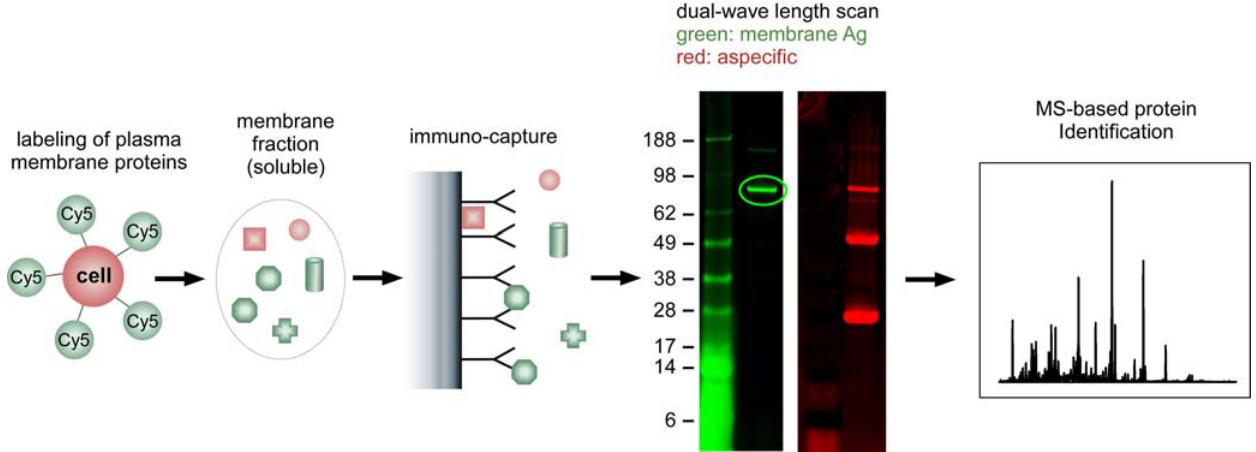
Figure 4. Schematic outline of the biochemical strategy adopted for the identification of the target antigens. Membrane proteins on living cells are selectively labeled with fluorescent dyes (i), then isolated in native conformation and in soluble form by extraction with appropriate buffers (ii). The target antigen is pulled down using the beads-immobilized IgG of interest (iii). Immuno-purified material is analyzed by 1D-PAGE and membrane proteins discriminated from non-specific binders by dual-wavelength scan of the gel (iv). Positive band is excised and processed for MS-based protein identification.